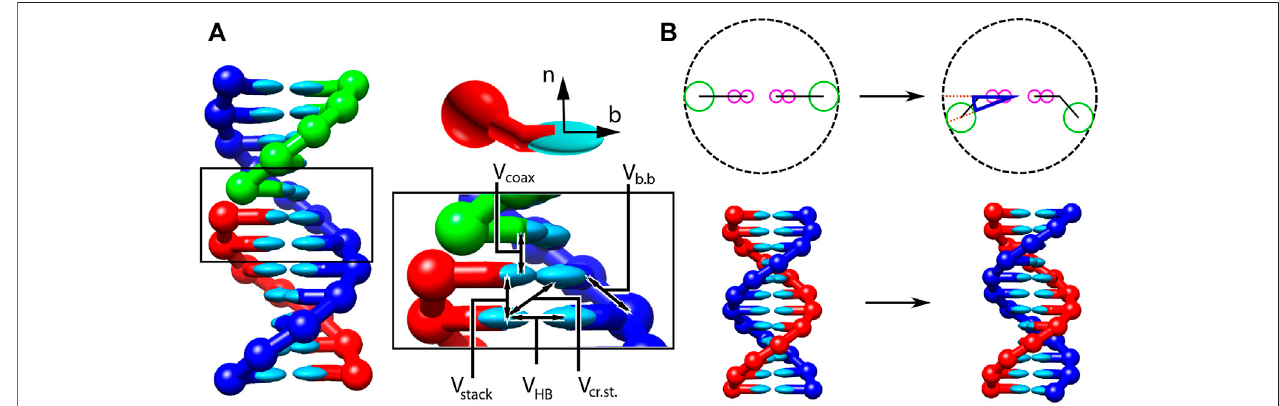
FIGURE 1 | Structure and interactions of the oxDNA model (adapted from (Snodin et al., 2015; Doye et al., 2020). (A) Three strands forming a nicked duplex as representedbyoxDNA2.0,withthecentralsectionofthecomplexillustratingkeyinteractionsfrom Eq.2 highlighted.Individualnucleotideshaveanorientationdescribed byavector normal totheplaneofthebase (labelledn), andavector indicating the directionofthehydrogen bondinginterface(labelledb). (B) Comparison ofstructurein oxDNA1.0 and oxDNA1.5 vs oxDNA2.0. In the earlier version of the model, all interaction sites are co-linear; in oxDNA2.0, offsetting the backbone site allows for major and minor